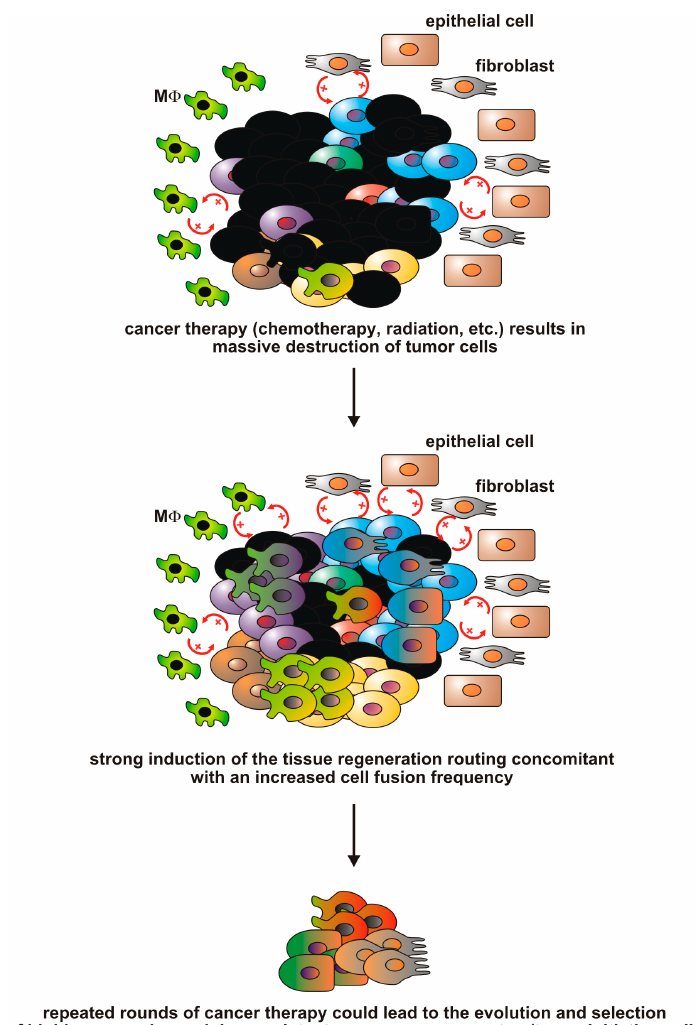
Figure 5. The causative correlation between cancer therapy and cell fusion events. Cancer therapy, e.g., chemotherapy and/or radiation therapy, will eliminate rapidly proliferating cancer cells. The accumulating tumor cell debris will initiate a local inflammation concomitant with induction of a macrophage driven wound healing/tissue regeneration response including cell fusion events. Repeating cycles and/or fractions of chemotherapy/radiation therapy could lead to the evolution and selection of cell fusion-derived recurrence cancer stem cells exhibiting a more malignant phenotype.